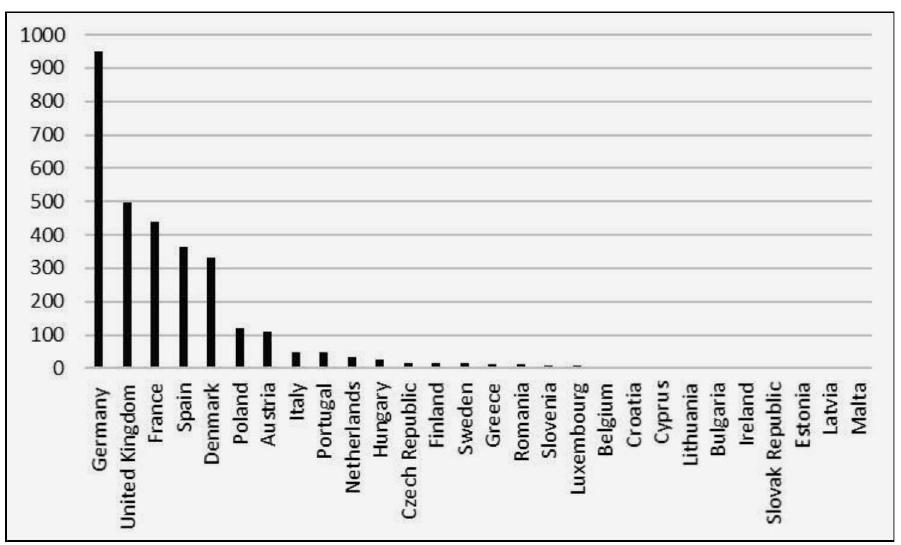
The number of patent registrations in technology of fuel cells and hydrogen production in European countries